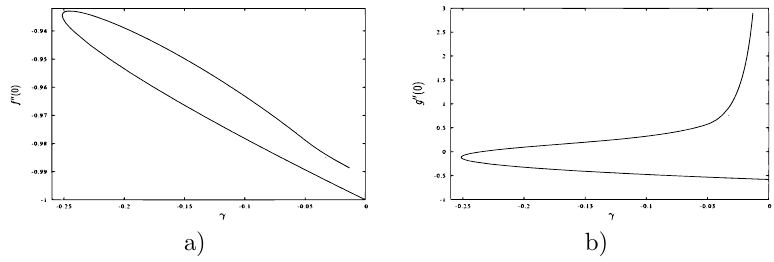
Figure 3. Impermeable surface, S = 0: plots of a) f (cid:48)(cid:48) (0) and b) g (cid:48)(cid:48) (0) against γ obtained from the numerical solution to equations (2.4)–(2.6), (2.8).